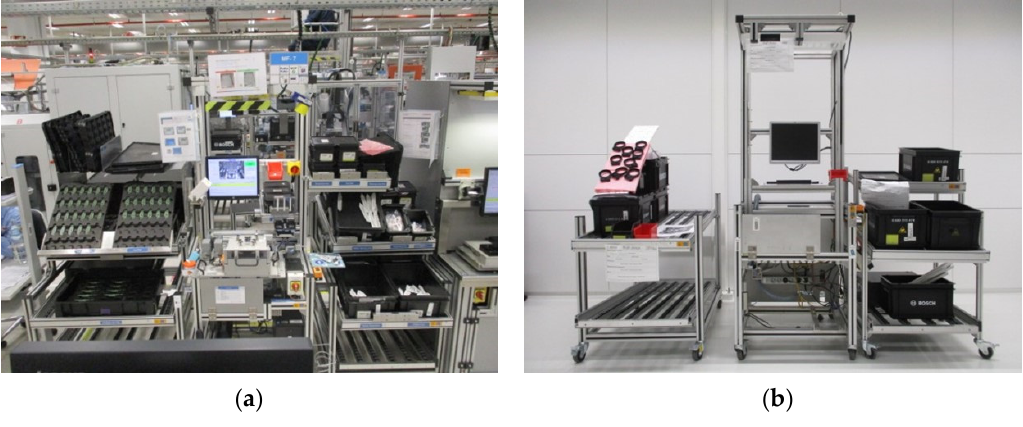
Figure 5. Workstation layout: ( a ) Original; ( b ) Replica.